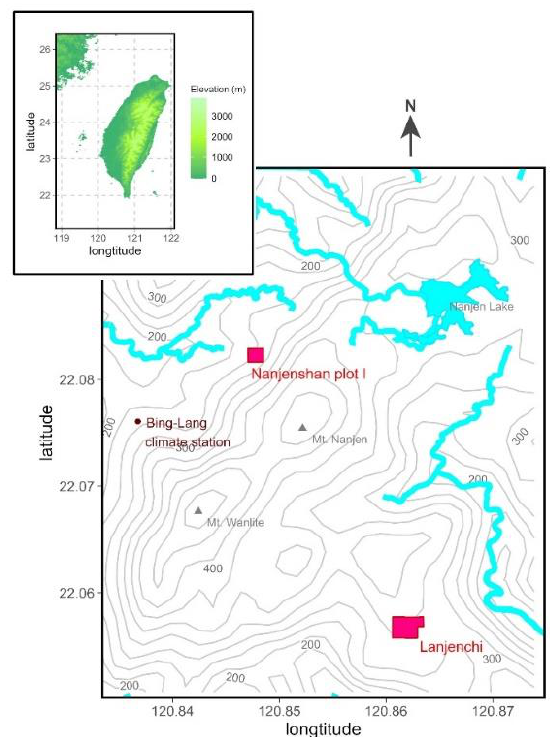
Figure 1. Map of the study sites.